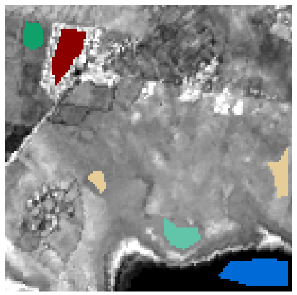
Figure 5. Training sites for supervised classification